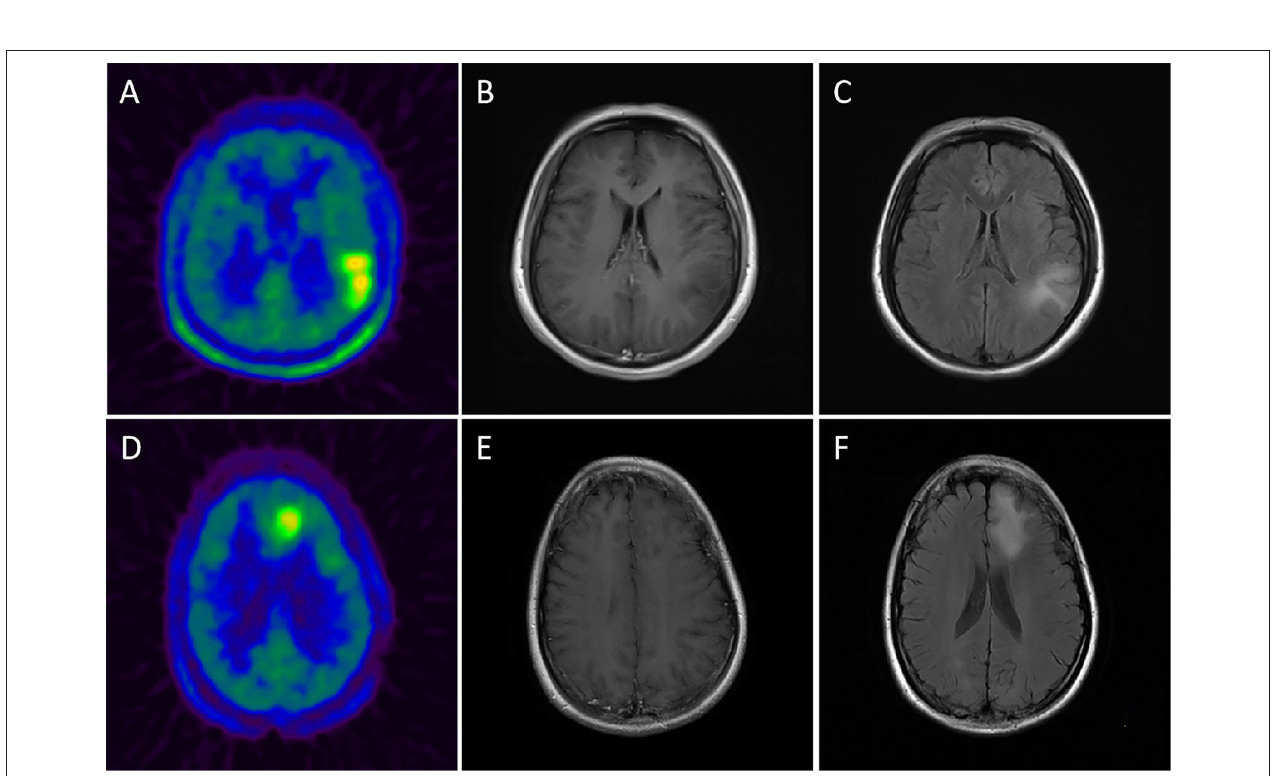
FIGURE 2 | Upper row: example of a patient with a 11 C-MET-positive lesion in the left temporo-parietal lobe, moderate TBRmax of 3.21 and moderate MTV of 46.1ml (A) without contrast-enhancement in CE-T1 MRI (B) and an obvious flair alteration in T2 MRI (C) but with a moderate SUV SD of 0.31 ( > 0.29); histopathological analysis revealed an IDH-wildtype, diffuse astrocytoma (WHO grade II). Lower row: example of a patient with a 11 C-MET-positive lesion in the left frontal lobe, moderate TBRmax of 2.46 and moderate MTV of 31.3ml (D) without contrast-enhancement in CE-T1 MRI (E) and a flair alteration in T2 MRI (F) but with a small SUV SD of 0.26 ( < 0.29); histopathological analysis revealed an IDH-mutant, diffuse astrocytoma (WHO grade II).